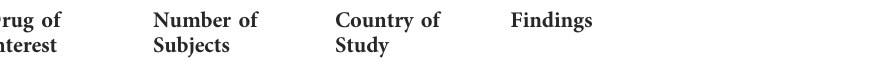
TABLE 2 Summary of trials of corticosteroid use in COVID-19. Drug of Number of Interest Subjects